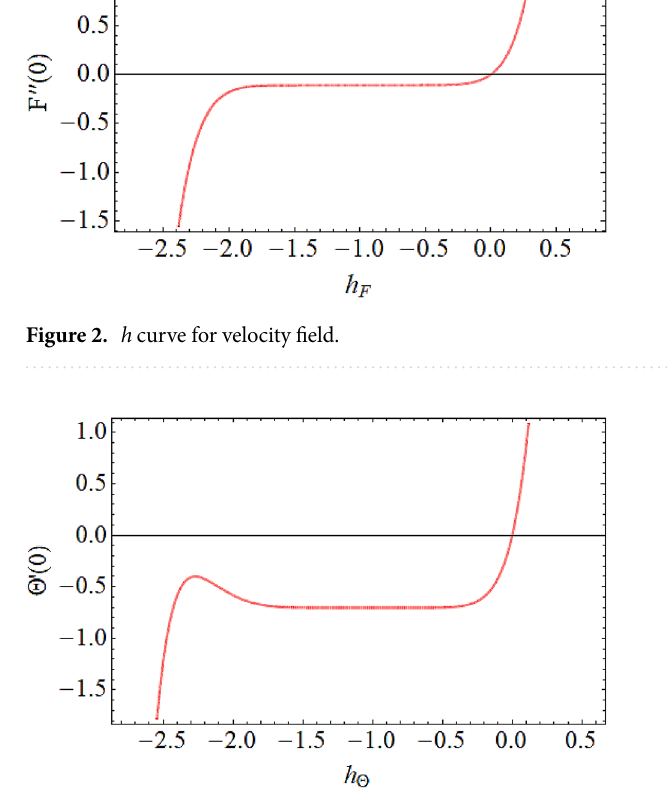
Figure 3. h curve for temperature